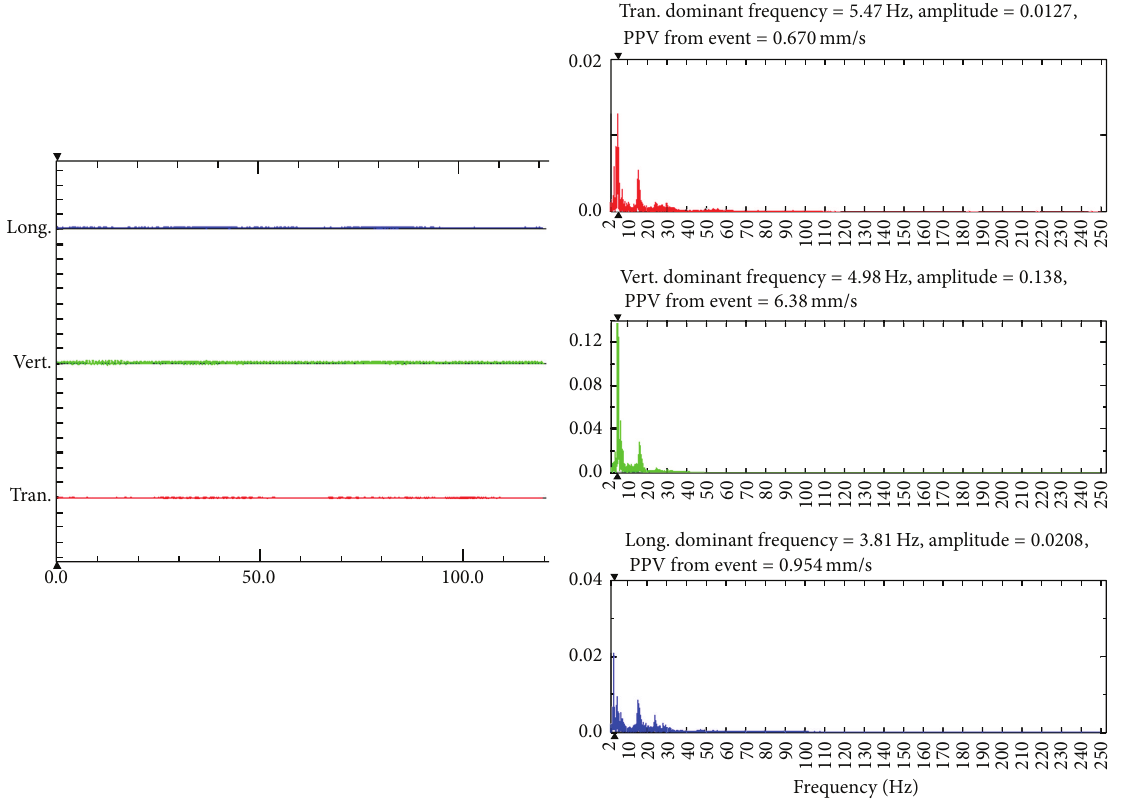
Figure 19: Measurement on base station 16R: velocity measurement in real time (120s recording) and frequency spectrums.